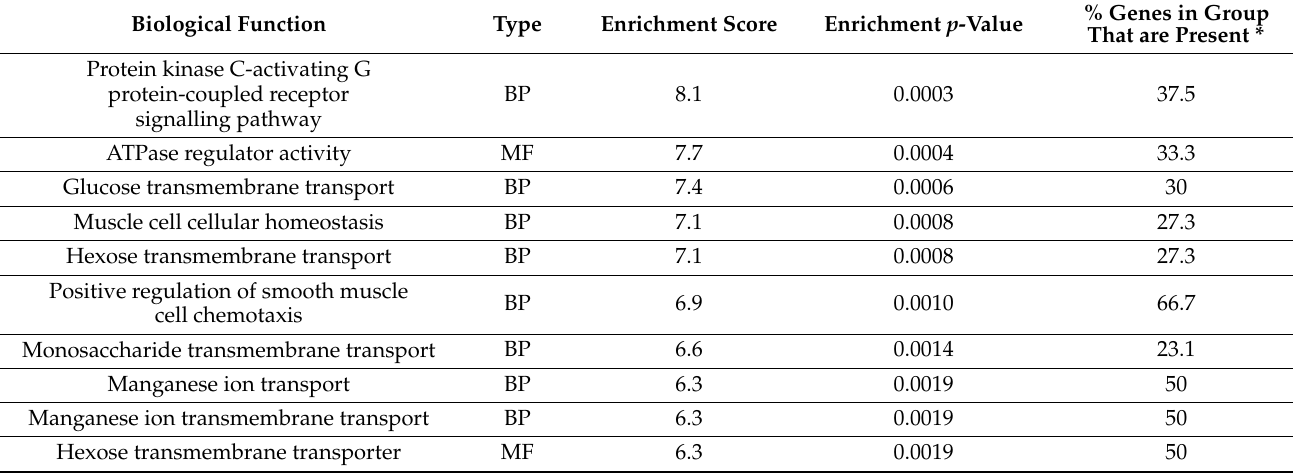
Table 1. Top ten most significant Gene Ontology (GO) terms for differentially expressed genes in vitrified blastocysts.